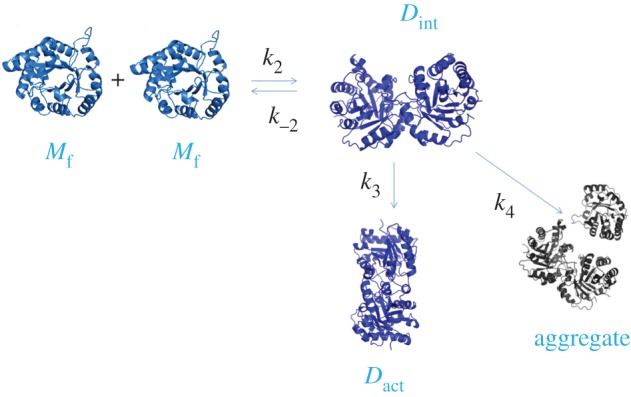
Model of protein folding used to calculate the velocity constants using the program DynaFit. M represents the monomer, Dint represents the intermediate dimer, Dact represents the active dimer and aggregate represents aggregates.